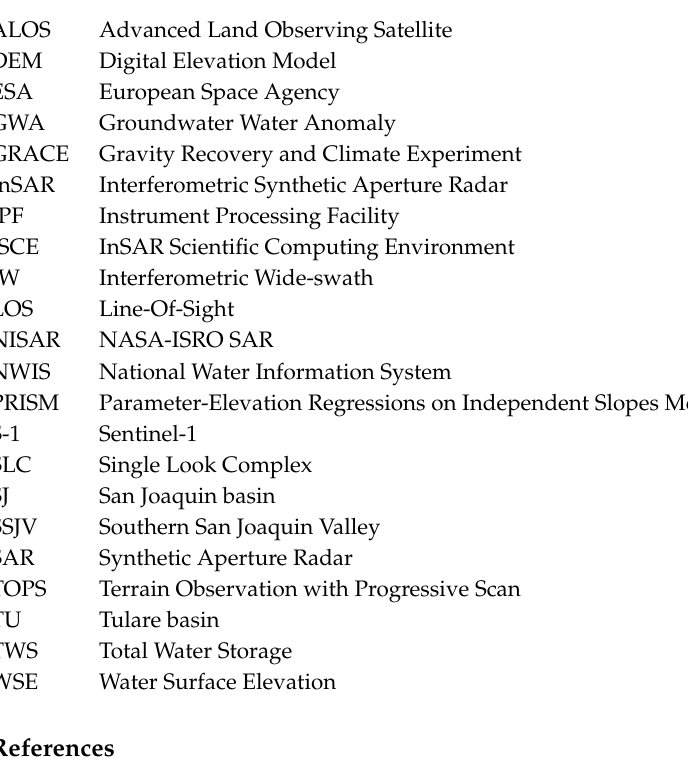
Figure S1: Example of interferograms after ionosphere noise correction and estimated ionosphere phase, Figure S2: The 3-component GPS position time series at station P305, Figure S3: Example of GRACE derived total water storage (TWS) change, groundwater anomaly, estimates of snow water equivalent, soil moisture, and surface water anomaly for the entire Central Valley, Figure S4: Mean LOS velocity map in 2006-2010 from L-band ALOS-1 ascending track 219 covering roughly the same area as Sentinel-1 data used in this study and selected velocity profile, Figure S5: Mean LOS velocity in 2006–2010 from ALOS-1 ascending track 218 in southern San Joaquin Valley basin, south of the Sentinel-1 track used in this study. LOS subsidence time series at GPS stations LEMA and CRCN and corresponding histogram of temporal correlation between GRACE GWA and subsidence time series at these stations, Table S1: S1 raw data list, perpendicular baseline, time separation, Table S2: Continuous wells’ IDs, longitudes, latitudes, and